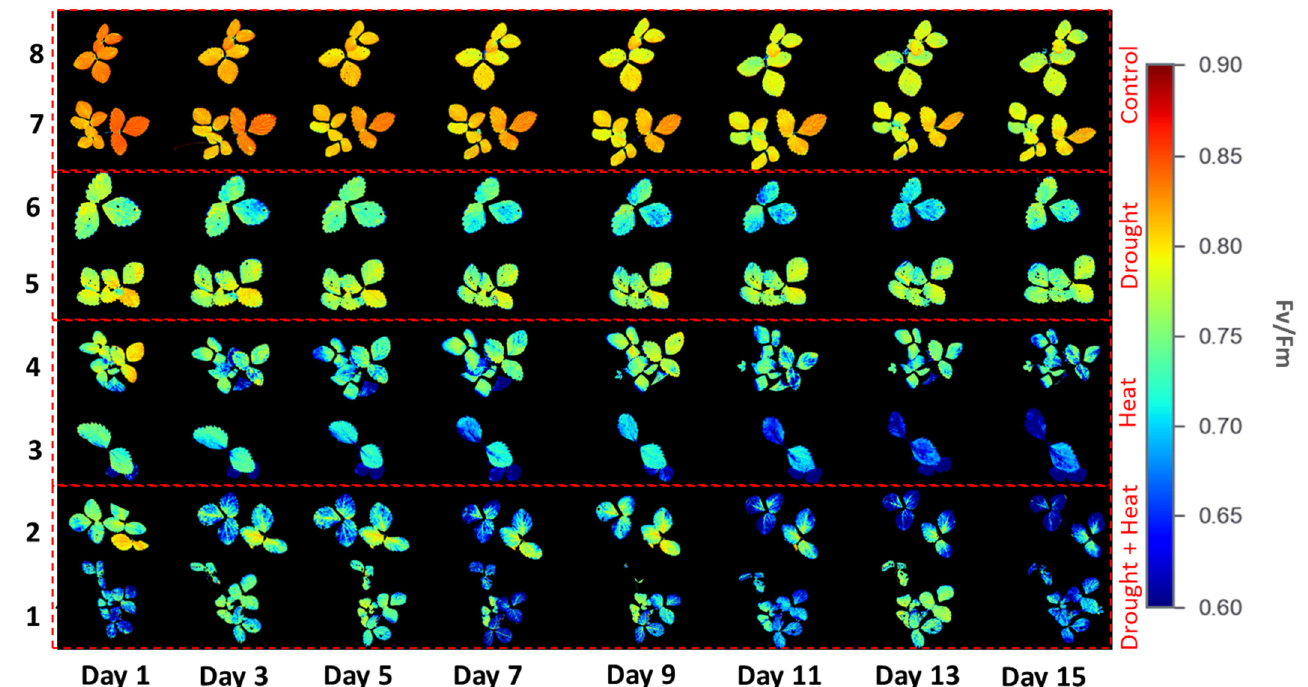
Figure 6. Chlorophyll fluorescence images from four different treatment groups.